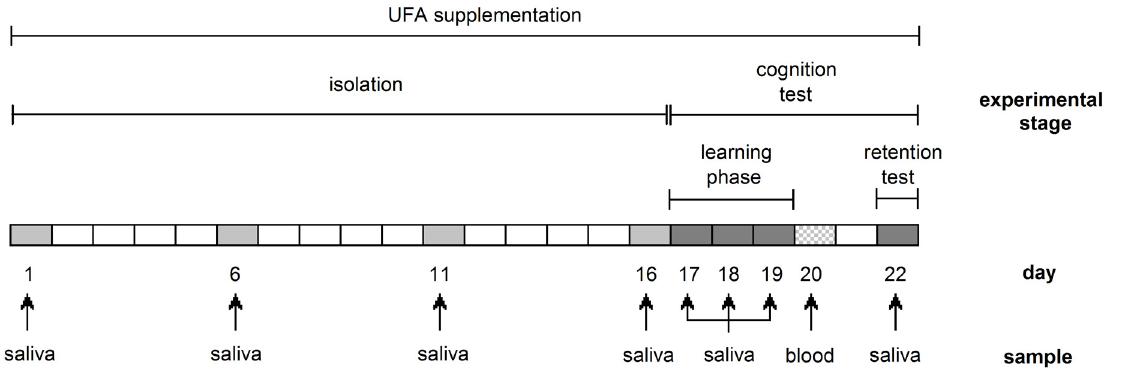
Fig 1. Experimental time-line for the whole experimental procedure (22